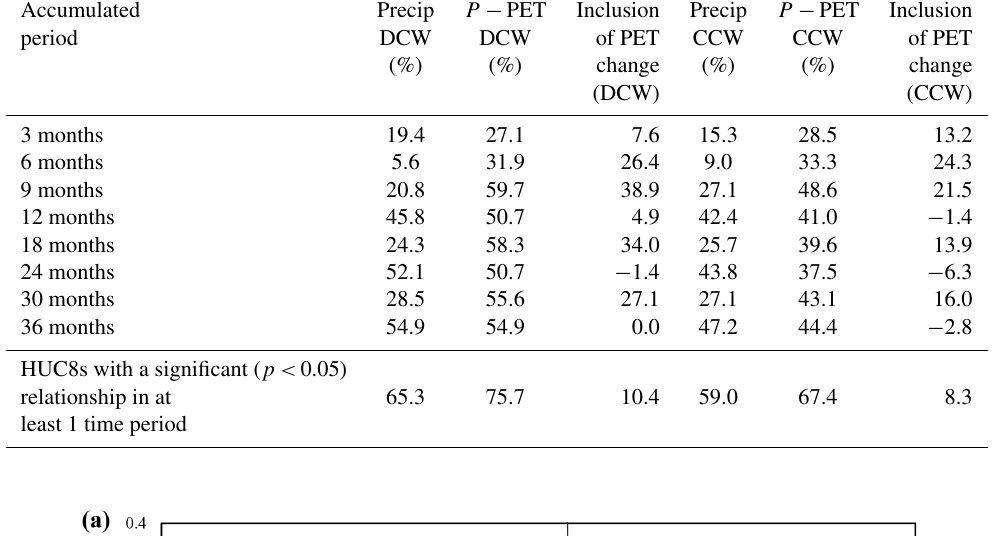
Table 5. The percent of HUC8s across the study area that showed a significant relationship ( p < 0.05) between surface water extent and (1) precipitation (Precip or P ) or (2) precipitation minus potential evapotranspiration (PET) for different accumulation periods. DCW – disconnected surface water; CCW – continuously, connected surface water.